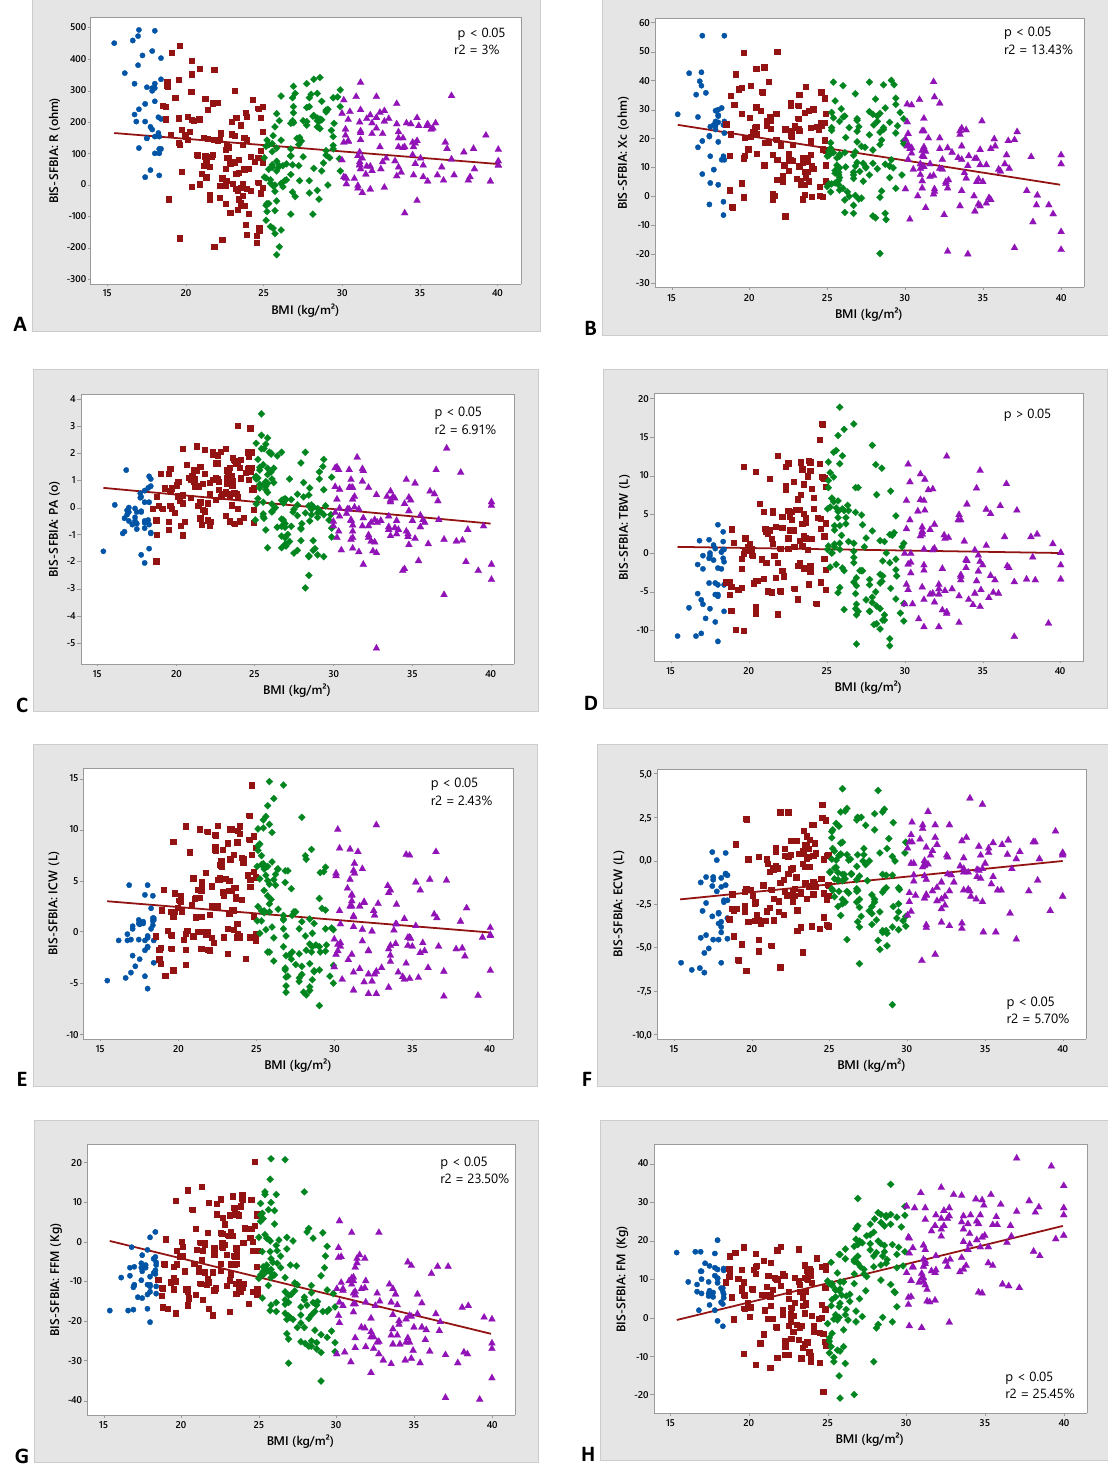
Figure 1: Regression analyze between BIS and SFBIA bias (BIS-SFBIA) with BMI. Data analyzed only for BMI subgroups. BIS, multifrequency bioelectrical impedance spectroscopy; BMI, body mass index; ECW, extracellular water; FFM, fat free mass; FM, fat mass; ICW, intracellular water; PA, phase angle; R, resistance; SFBIA, single-frequency bioelectrical impedance; TBW, total body water; Xc, reactance. (a) R; (b) Xc; (c) PA; (d) TBW; (e) ICW; (f) ECW; (g) FFM; (h) FM. Circle: underweight; Square: normal weight; Trapezium: overweight; Triangle: